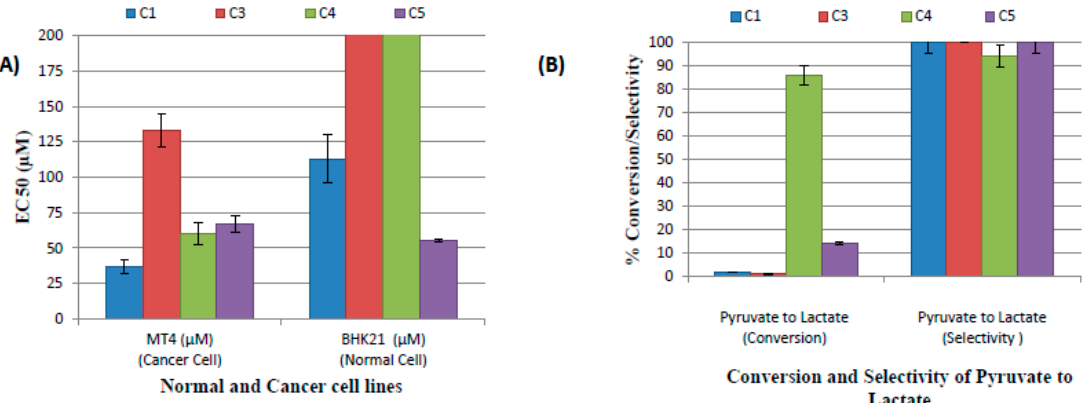
Figure 2. ( A ) Effective concentration (EC 50 ) of compounds resulting in 50% cell viability decrease determined using the colorimetric MTS assay for complexes C1 , C3 – C5 ( A ) as evaluated against normal kidney cells (BHK21) and Leukemia cells (MT4), and ( B ) comparative graphs showing the catalytic conversion and selectivity for the transformation of pyruvate to lactate by complexes C1 , C3 – C5 . Error bars represent standard deviation from the mean for n = 6 in the case of cytotoxic evaluation and mean ± SD for n = 3 catalytic runs.